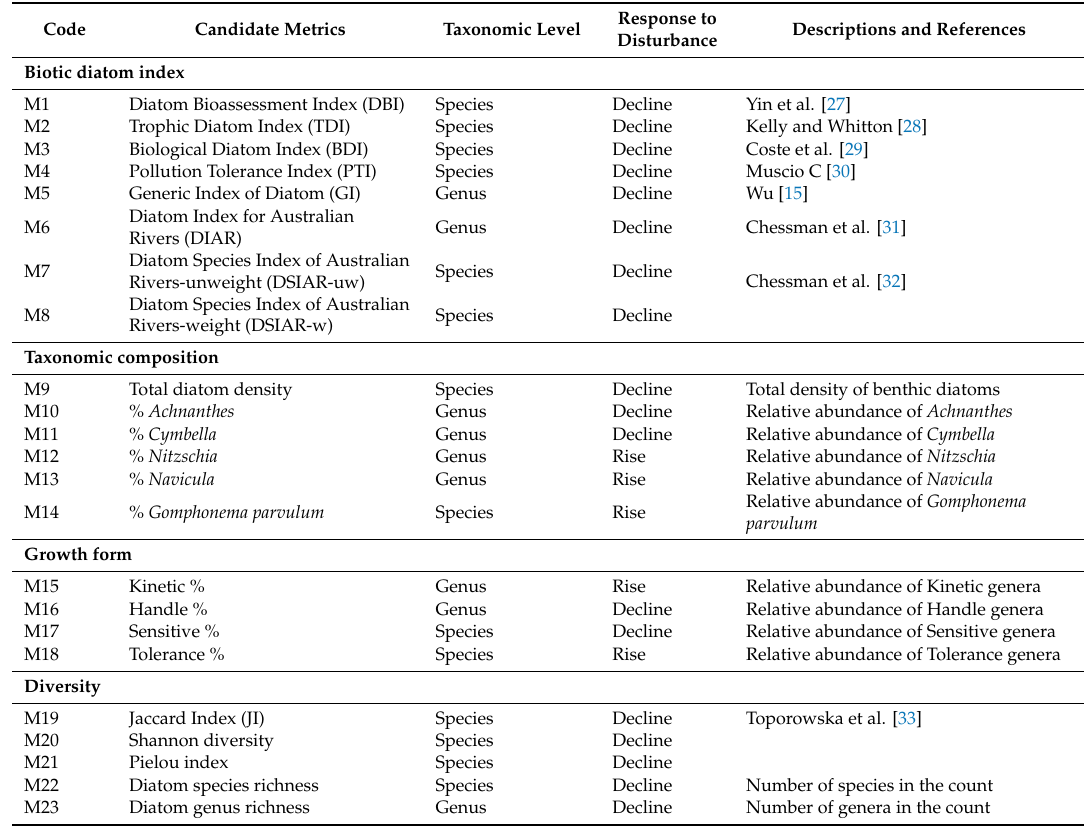
Table 1. Attribute and description of candidate metrics of benthic diatom index of biotic integrity (BD-IBI) in Wutong